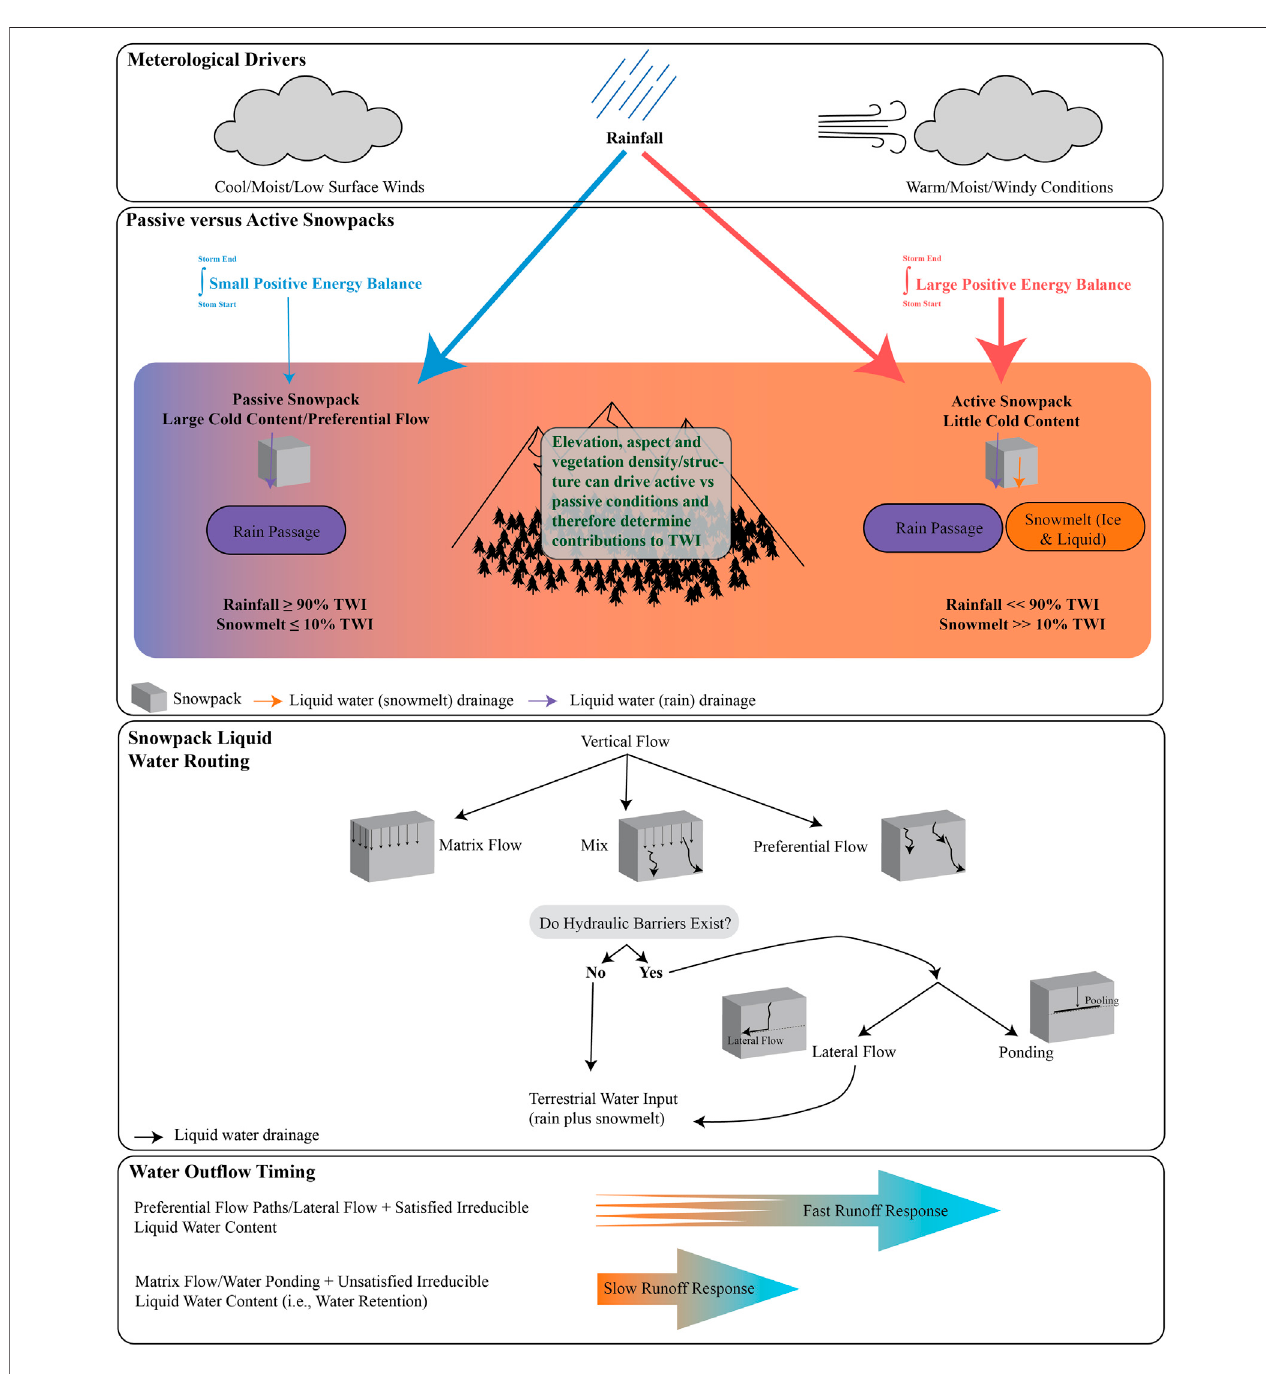
FIGURE 2 | A conceptual diagram connecting meteorological drivers for active vs. passive snowpacks to snowpack liquid water routing and fi nally the speed of water out fl ow. Note: for a more detailed description of hydraulic barriers with regards to water routing within the snowpack see Webb et al. (2018a).